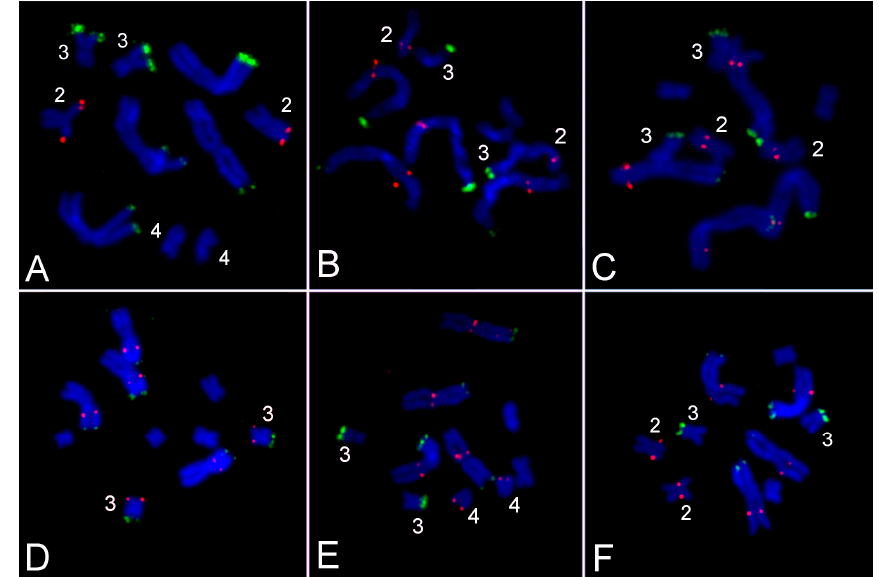
Figure 7. Localization of rDNA repeats and unique DNA fragments. ( A ) Clusters of 28S (green) and 5S (red) rDNA; ( B ) 28S rDNA (green) and unique DNA sequence R1 (red); ( C ) 28S rDNA (green) and unique DNA sequence R2 (red); ( D ) 28S rDNA (green) and unique DNA sequence R3 (red); ( E ) 28S rDNA (green) and unique DNA sequence R4 (red); ( F ) 28S rDNA (green) and unique DNA sequence R5 (red) in the M. lignano chromosomes. Metaphase chromosomes were stained with DAPI (blue). Genes 2017 , 8 , 298